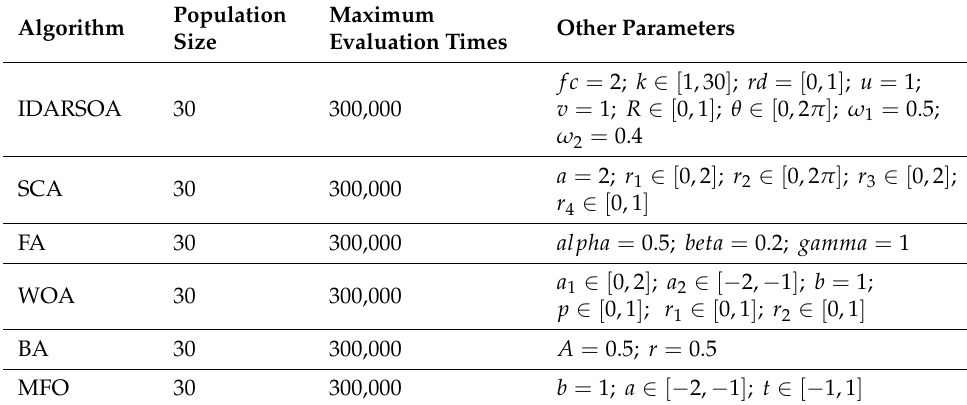
Table 7. Parameter settings of original algorithms.